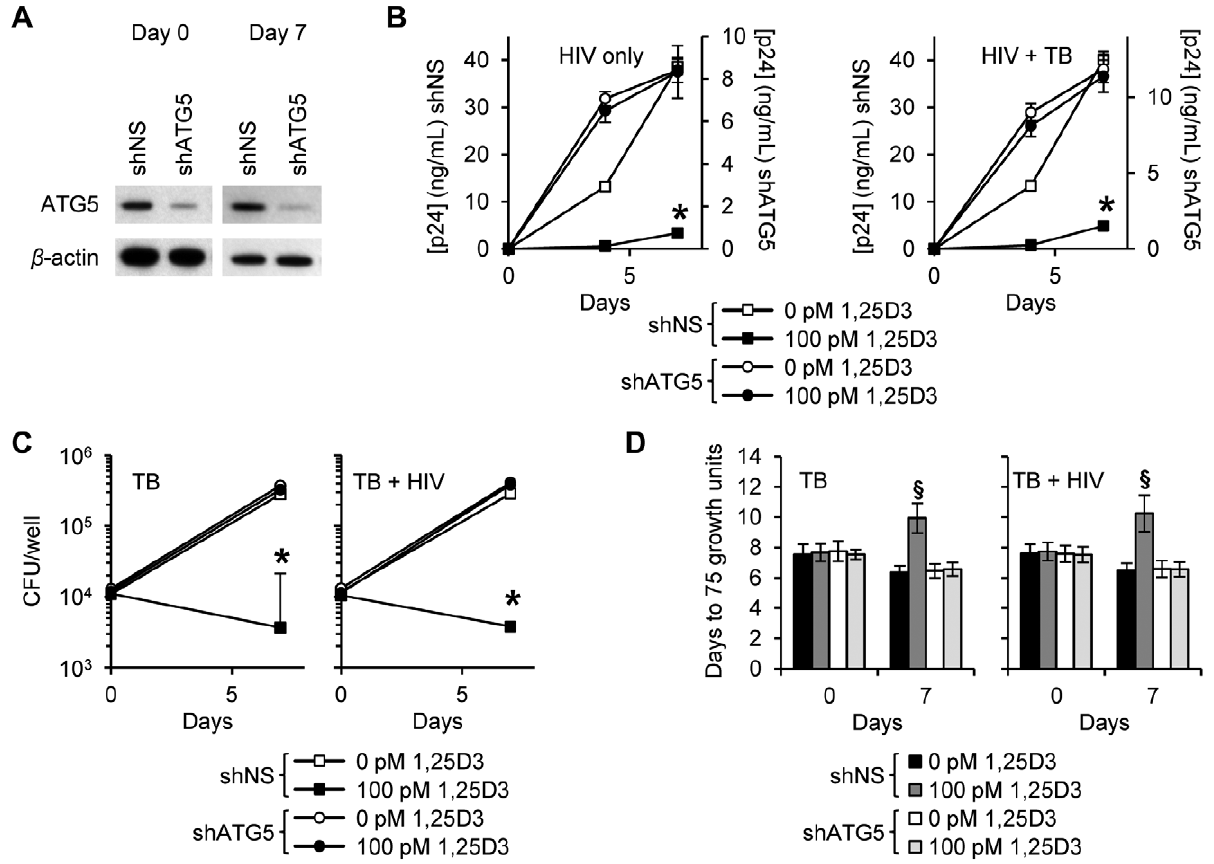
Figure 5. 1,25D3 inhibition of HIV and M.tuberculosis is ATG5 dependent. MDM were transduced with non-specific scrambled shRNA (shNS) or ATG5 shRNA (shATG5) and selected using puromycin resistance. Five days later, cells were incubated with 100 pmol/L 1,25D3 or vehicle control for 4 h before infection with HIV and/or M. tuberculosis (TB) for 3 h. Cells were then washed and incubated with 100 pmol/L 1,25D3 or vehicle control for 7 days. (A) Immunoblot analysis performed using antibodies raised to ATG5 or b -actin after initial pathogen exposure (Day 0) or after 7 days. (B) ELISA performed for HIV p24 antigen release over 7 d. (C) Intracellular mycobacteria were harvested and assayed for mycobacterial growth by cfu enumeration at day 0 and day 7. (D) Intracellular mycobacteria harvested and assayed for viability based on time to positivity (75 growth units) at day 0 and day 7 using the MGIT 960. All bar and line graphs are reported as mean 6 s.e.m. of three independent experiments performed in triplicate. 1 P , 0.05; * P ,